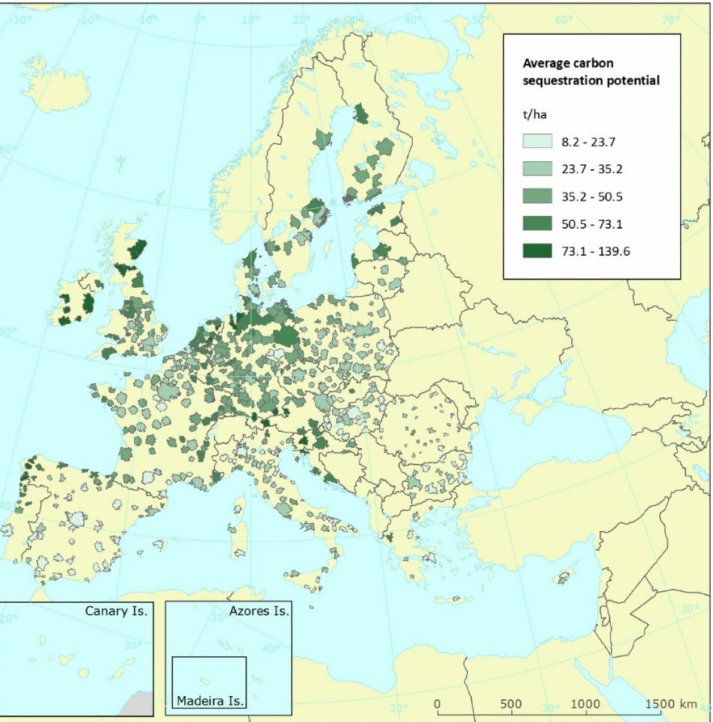
Figure 5. Estimated carbon sequestration potential (t/ha) in soils of the Functional Urban Areas.